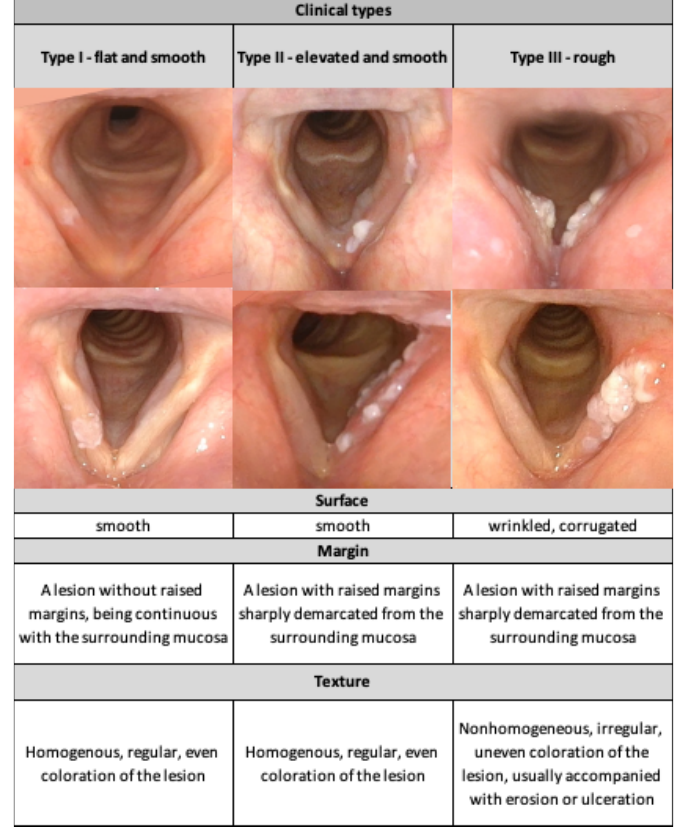
Figure 1. Morphological types of leukoplakia according to Chen (2019) [23], based on the authors’ repository images from patients with VFL (N = 98) who were enrolled in the study.